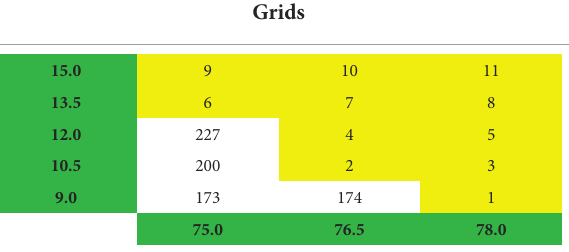
Longitude of the Altitude of the study area/site study area/site